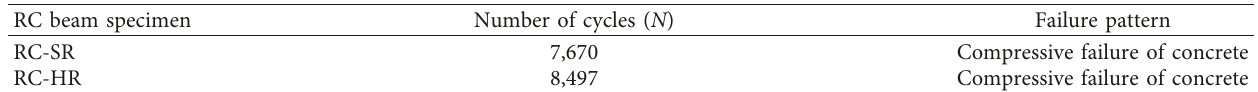
Figure 15: Comparison of predicted and experimental fatigue test results of RC-HR: (a) fatigue load-deflection curves at midspan of RC- HR; (b) fatigue load-tensile strain curves in longitudinal reinforcement of RC-HR; (c) fatigue load-concrete compressive strain curves of RC-HR. Table 4: Results of fatigue